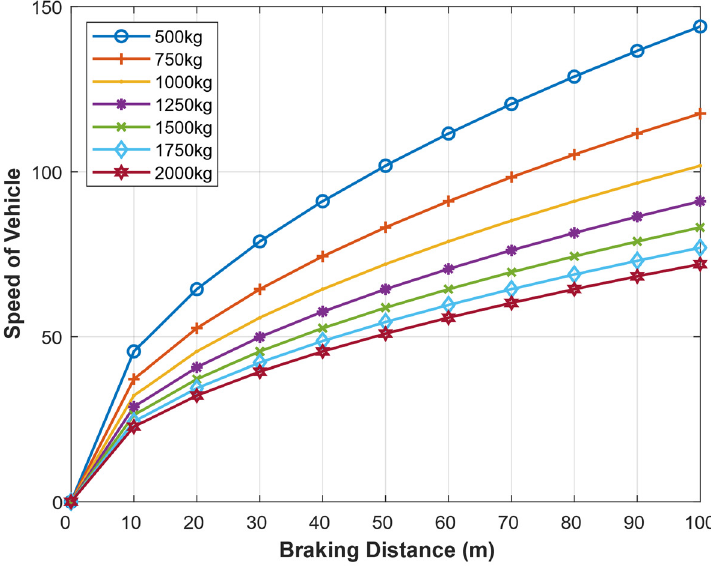
Figure 23. Maximum speed of a Vehicle given the braking distance with different masses of the vehicle.